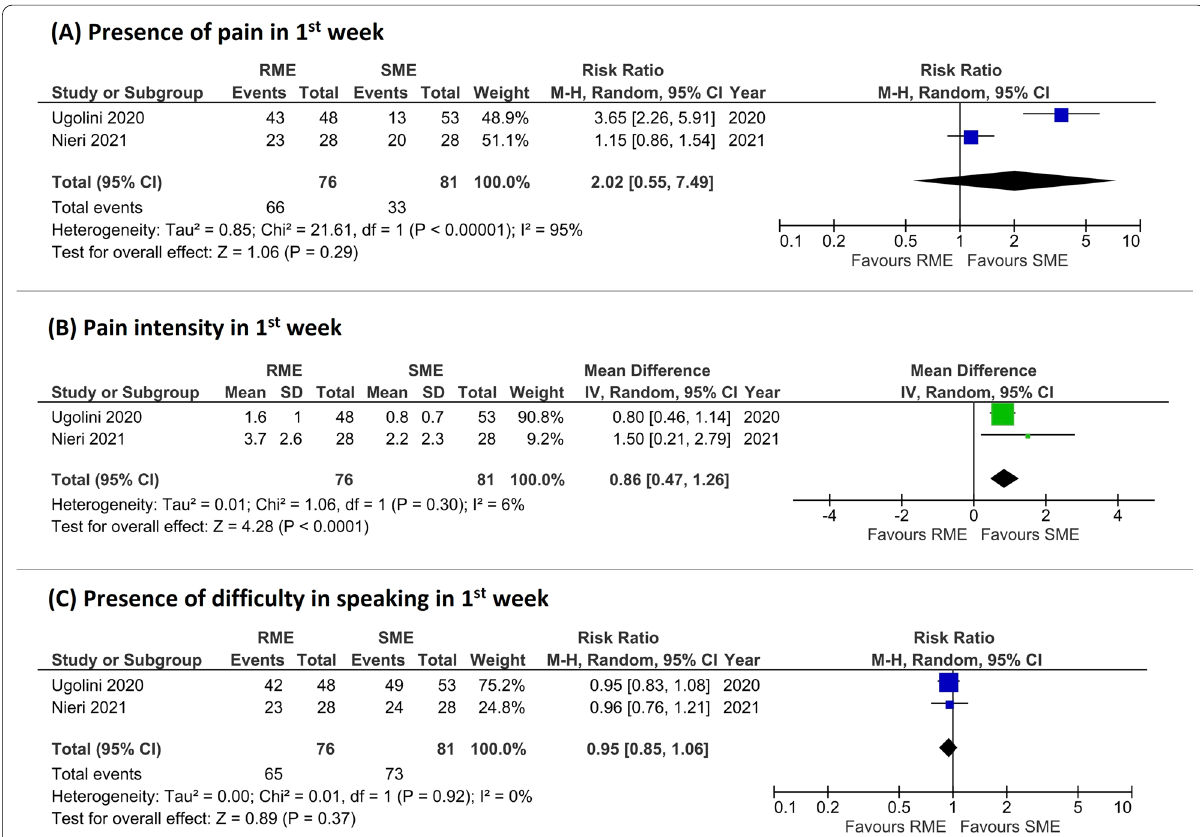
Fig. 3 Forest plots of the outcomes included in the meta-analysis ( A , presence of pain in 1st week; B , pain intensity in 1st week; C , presence of difficulty in speaking in 1st